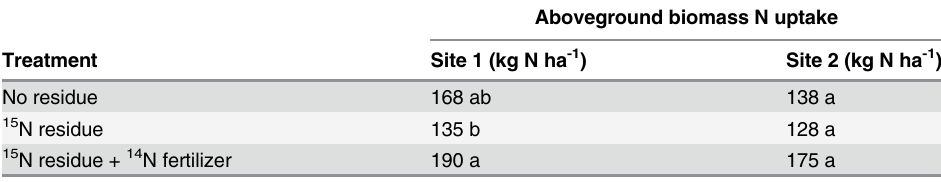
Table 3. Total aboveground biomass (straw + grain) N uptake in 15 N-labeled residue